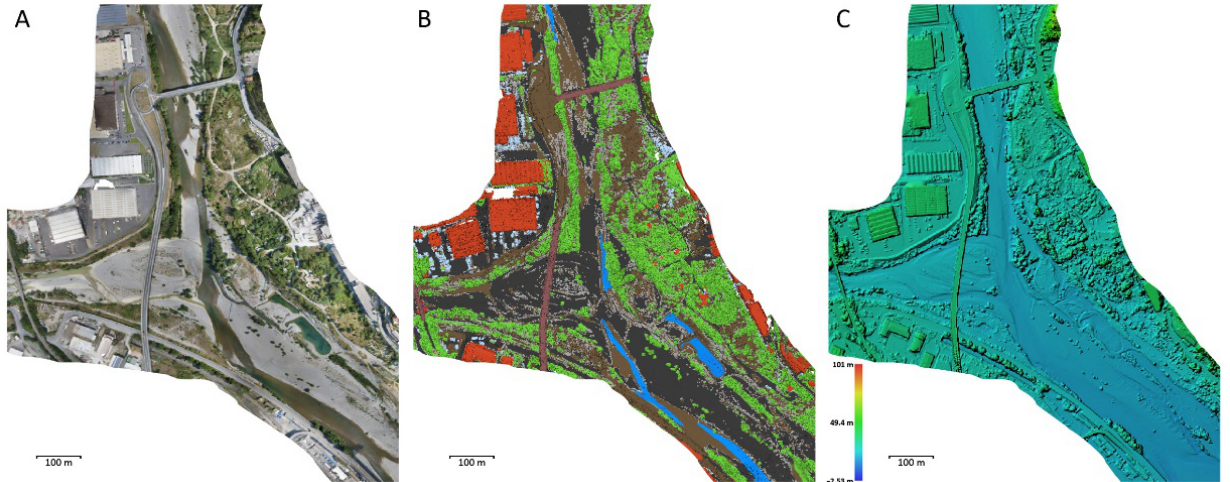
Figure 5. Products obtained by the 2018 survey. ( A ) Orthophoto; ( B ) classified dense cloud. In green, light blue, black, brown, and red are colored vegetation, deep water, riverbed, streets, and buildings, respectively. ( C ) Digital surface model (DSM). Table 2. Main features and resolution of the obtained